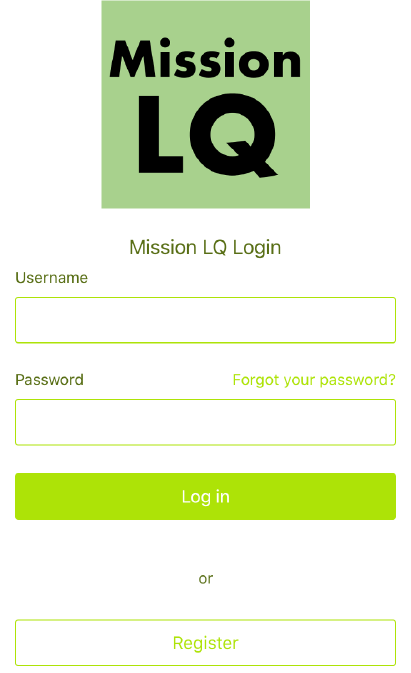
Figure 4. Log in screen for Mission